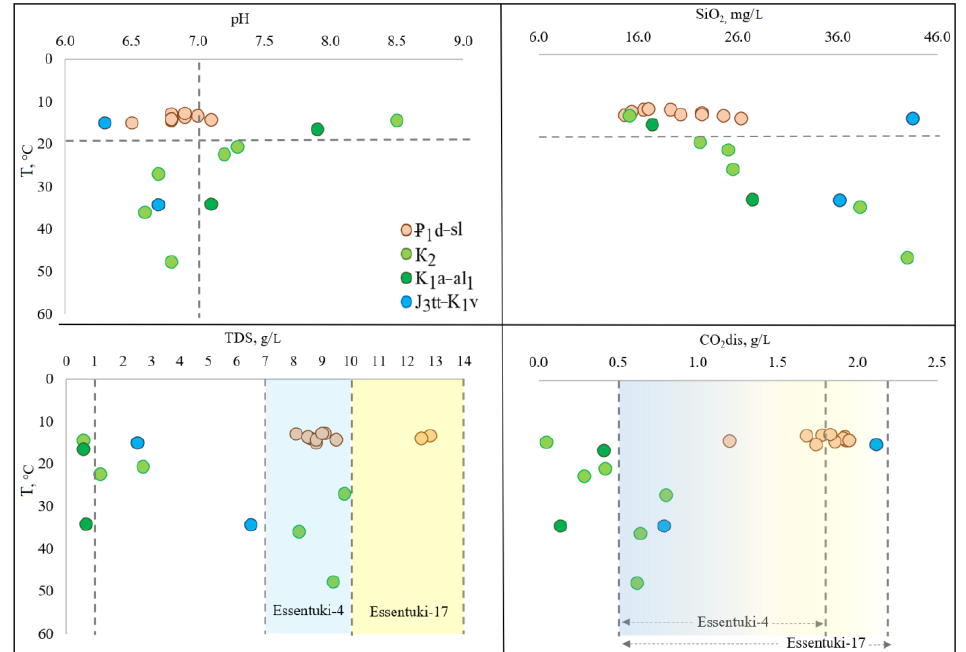
Figure 4. Relationship between temperature (T, °C), TDS, pH, SiO 2 and dissolved carbon dioxide (CO 2 , g/L) for the water samples in the study area.